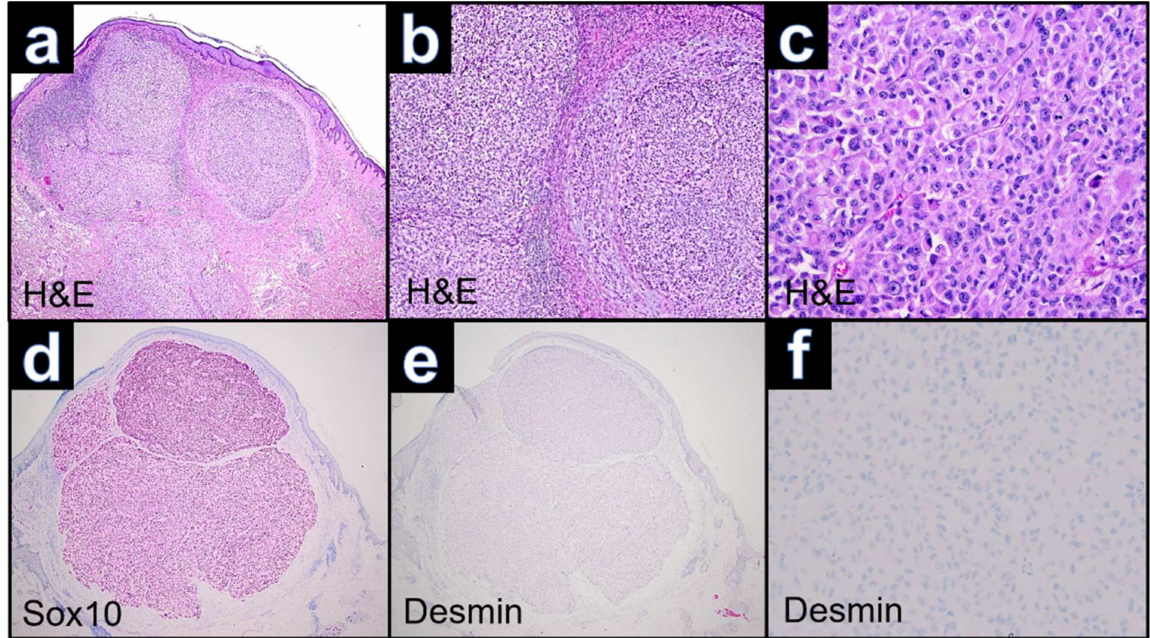
Figure 4. Case WUE3: ( a ): Panoramic view showing an ulcerated, relatively well-circumscribed elevated nodular lesion involving the dermis and subcutis (H&E, × 40). ( b ): Proliferation of nests or sheets of atypical polygonal neoplastic cells (H&E, × 100). ( c ): Neoplastic cells with eccentrically located large round-to-oval nuclei containing conspicuous nucleoli and eosinophilic inclusions within the rich cytoplasm (H&E, × 400). ( d ): Expression of Sox10 in rhabdoid differentiated melanoma cells. ( c , f ): Absence of desmin expression in rhabdoid differentiated melanoma cells (Desmin × 40, ×